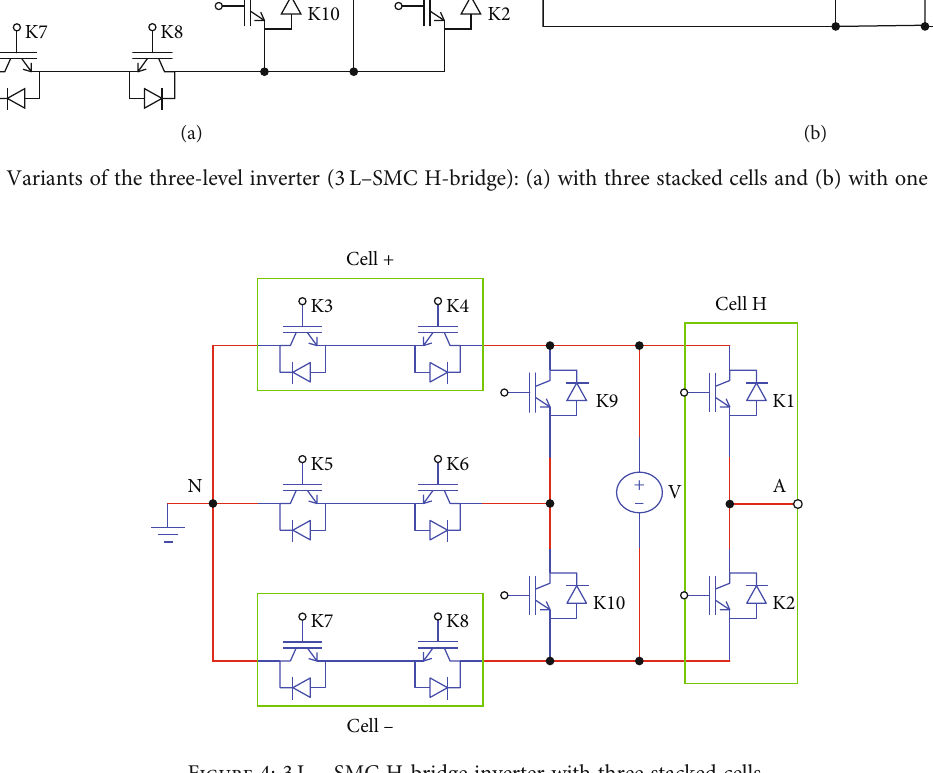
Figure 4: 3L – SMC H-bridge inverter with three stacked cells. Table 1: Possible states of the switches and the output voltage of the